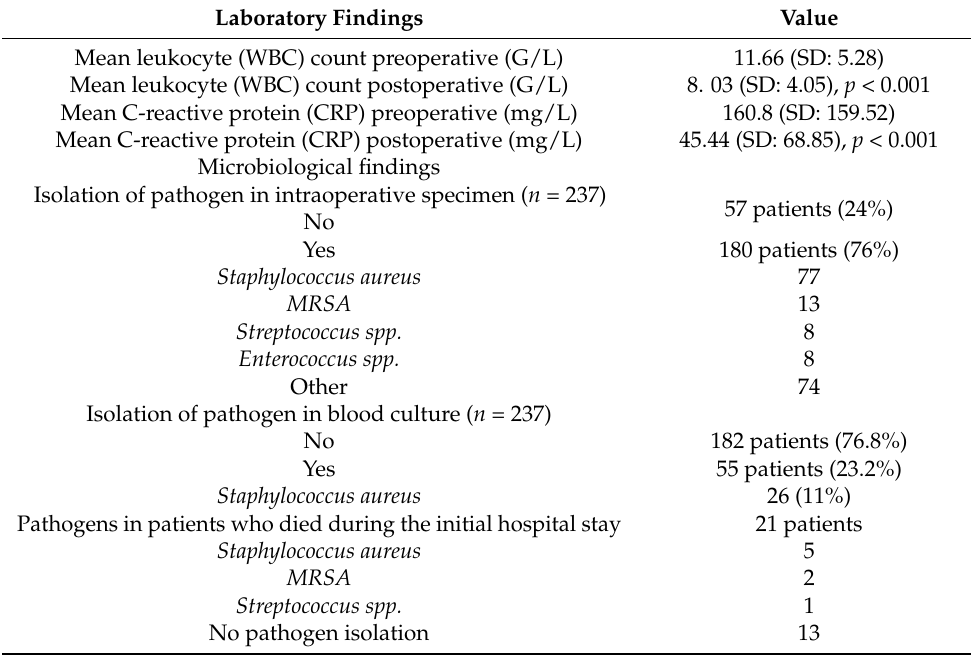
Table 3. Laboratory and microbiological findings.